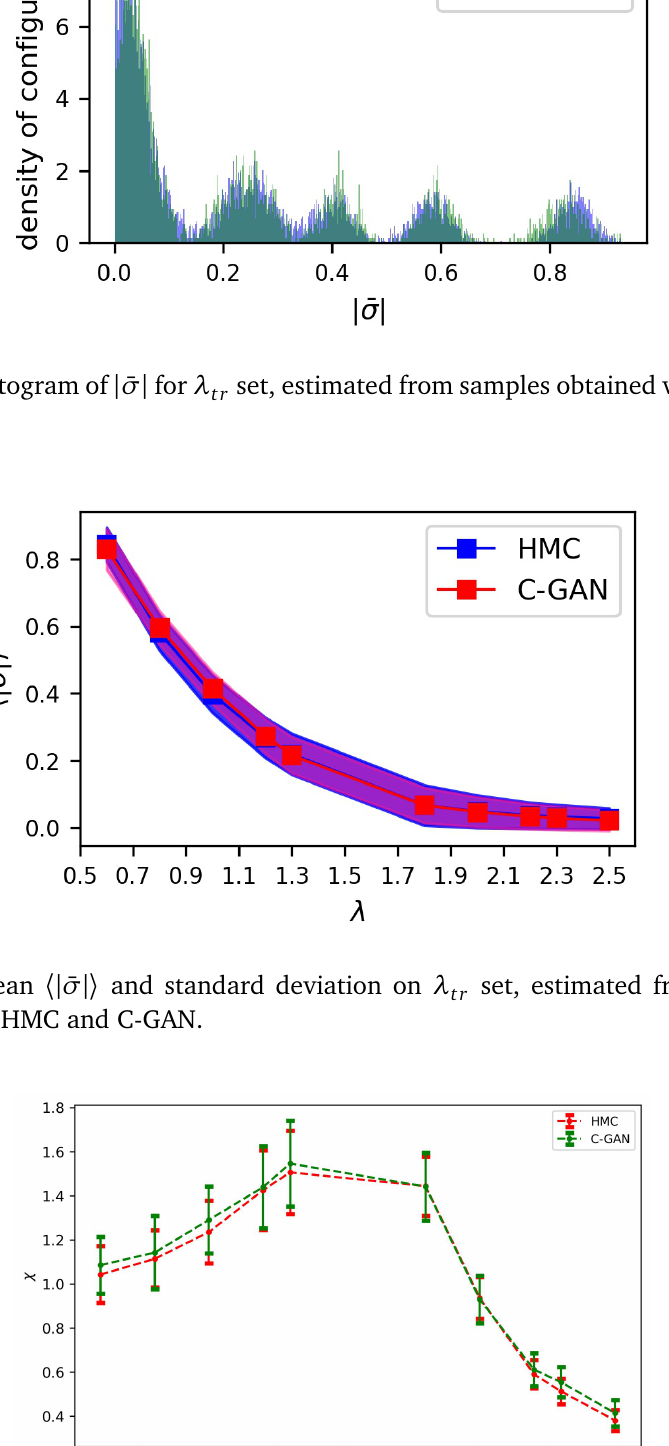
set, estimated from 8000 tr